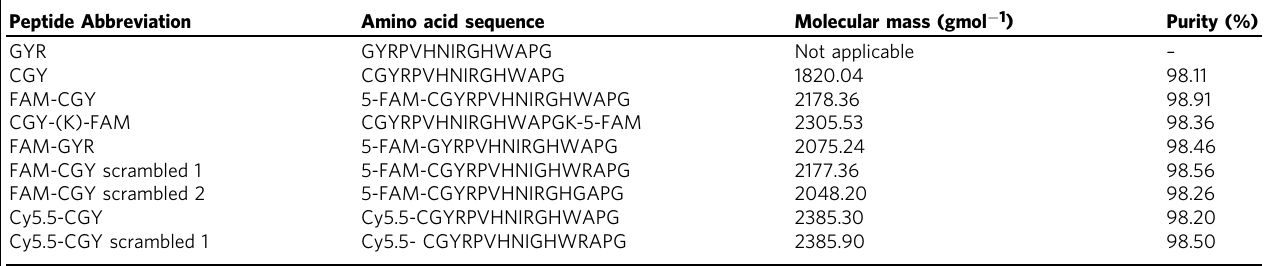
Table 1 Peptide and fl uorophore-peptide conjugate description Peptide